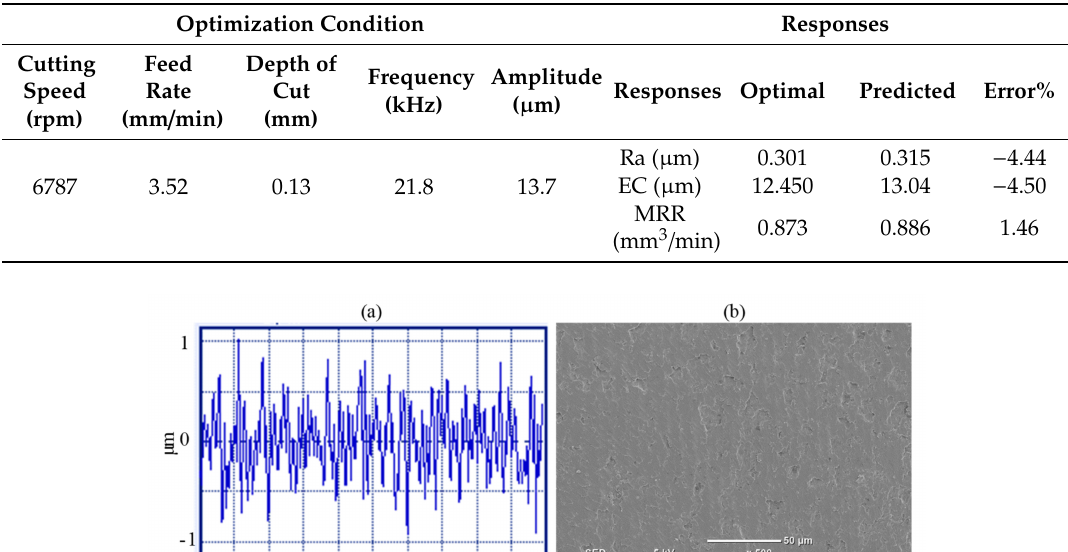
Table 10. Experimental results for Ra, EC, and MRR at optimized settings and confirmatory results